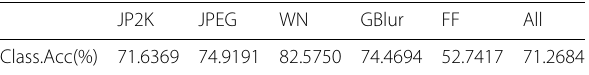
Table 6 Mean classification accuracy across 1000 train-test trials